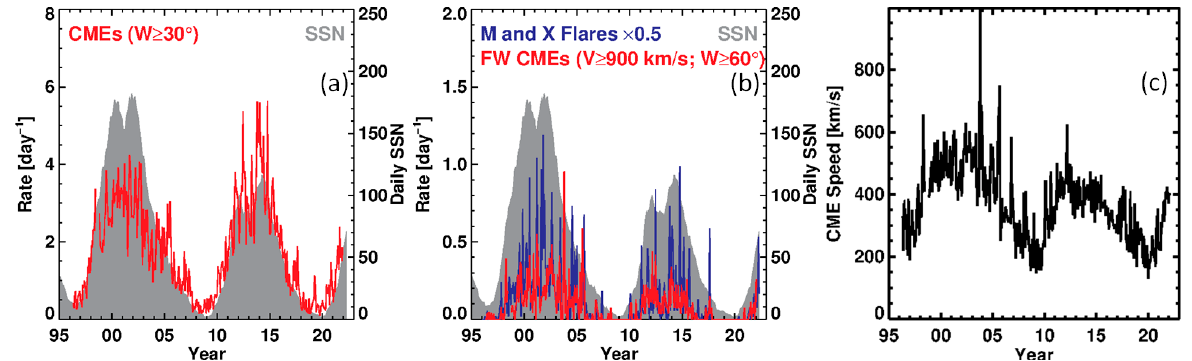
Figure 19. The occurrence rate of ( a ) regular (width ≥ 30°) and ( b ) fast and wide (FW) CMEs, observed by SOHO/LASCO (in red) since 1996 (superposed on the daily SSN in gray). Also shown in blue are the number of major X-ray flares (M and X class) in ( b ). ( c ) CME speed averaged over Carrington rotation periods.